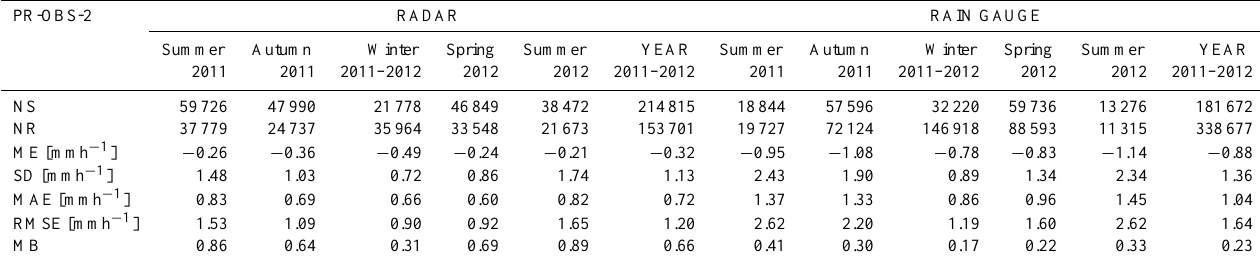
Table 8. Continuous indicators for PR-OBS-2: NS (number of considered satellite product samples); NR (number of reference field samples); ME (mean error); SD (standard deviation of ME); MAE (mean absolute error); RMSE (root mean square error); MB (multiplicative